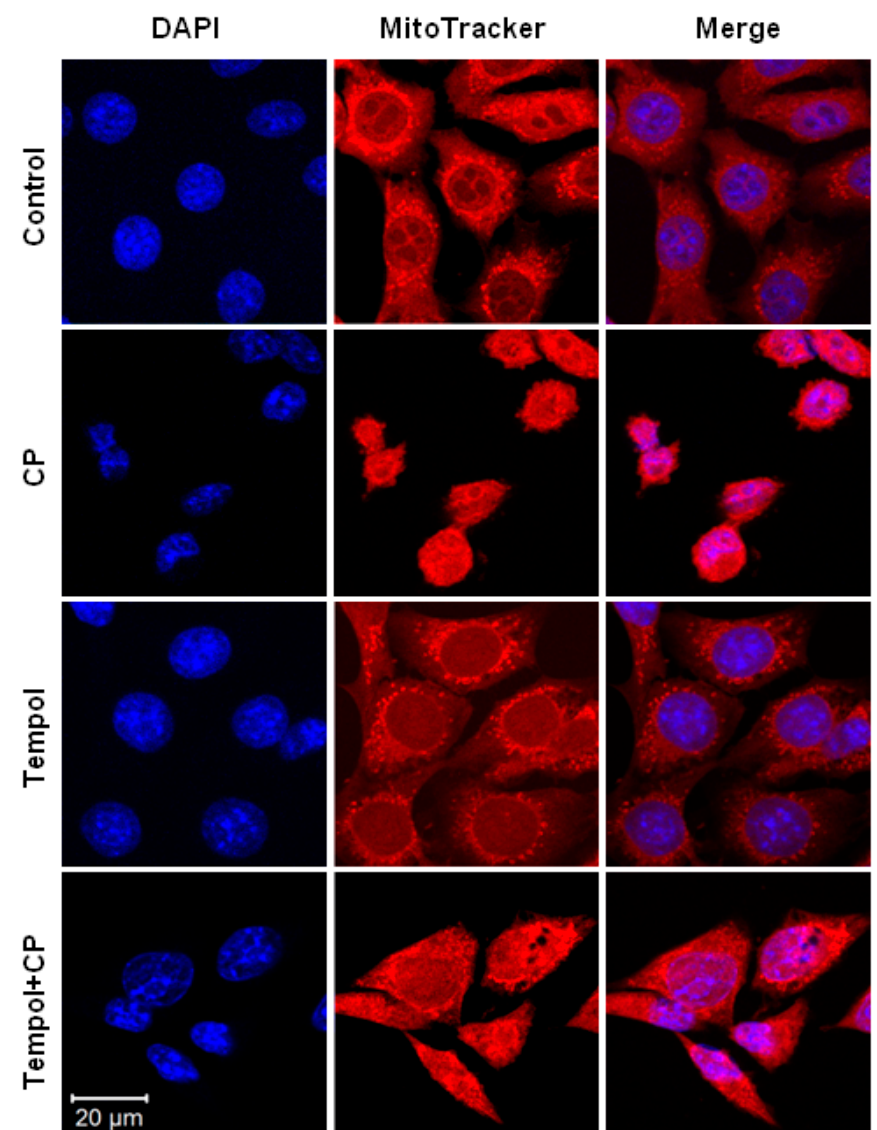
Figure 5. Confocal microscopic evaluation of the mitochondria and nuclei in HEI-OC1 cells. Cells seeded on coverslips were treated with 30 μ M cisplatin for 24 h with or without pretreatment with 50 μ M Tempol for 2 h. Controls cells were not exposed to cisplatin or Tempol. The mitochondrial structures were detected by MitoTracker ® staining (red) in the control and Tempol-alone groups. In contrast, the mitochondrial structure decreased in the cisplatin-alone group (CP). Pre-treatment with Tempol before cisplatin exposure inhibited the cisplatin-induced mitochondrial and nuclear changes (Tempol + CP). All figures have the same scale bars.